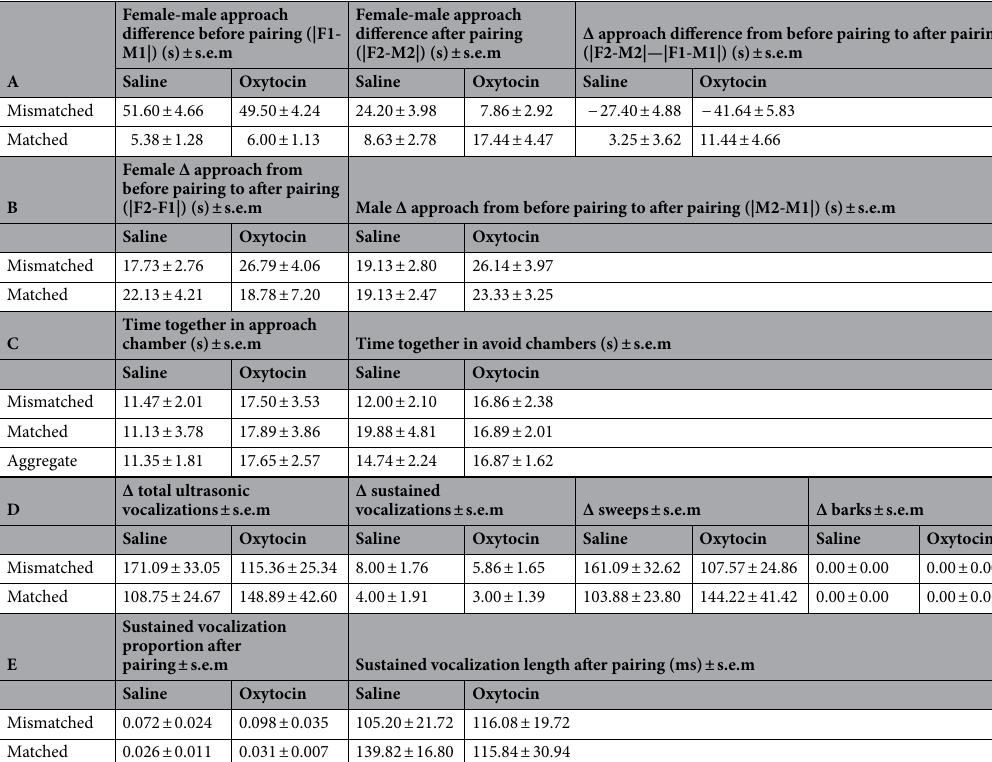
test than did saline individuals in mismatched pairs when controlling for sex, suggesting that the convergence in IN-OT mismatched pairs emerged from changes in approach by both sexes (F(1,84) = 5.257, p = 0.0244; Table 1B). IN–OT increased the amount of time pairs spent in joint approach. Complementing the analyses on the degree to which pair mates changed their behavior, we also measured time spent together as an indicator of coordination. Analysis of the amount of time paired mates spent together in either the approach chamber (the chamber closest to the bark playback speaker) or the avoid chamber (the chamber closest to the ambient noise speaker), via a 3-way interaction of pair type, treatment, and location, revealed that IN-OT spent signifi- cantly more time together in the approach chamber than saline pairs (F(1,84) = 4.311, p = 0.041) but not in the avoid chamber (F(1,84) = 0.092, p = 0.762), and no main effect of location (F(1,84) = 0.768, p = 0.383), pair type (F(1,84) = 1.645, p = 0.203), or the full interaction (F(1,84) = 0.967, p = 0.328; Fig. 3D; Table 1C). Additionally, there was a nonsignificant effect of pair type in the avoid chamber for saline groups (F(1,84) = 3.016, p = 0.086). A separate analysis that combined mismatched and matched pairs into a single category also revealed a signifi- cant main effect of IN-OT (F(1,88) = 4.066, p = 0.047), with a significant simple effect whereby IN-OT increased the amount of time pairs spent together in the approach chamber (F(1,88) = 4.543, p = 0.036) but not the avoid chamber (F(1,88) = 0.519, p = 0.473). There was also no effect of location (F(1,88) = 0.389, p = 0.535) or the inter- action of treatment and location (F(1,88) = 0.996, p = 0.321). Additionally, we did not observe any classic rodent courtship behaviors, including anogenital sniffing or following behavior (i.e. pursuing), that also occur in Cali- fornia mice 59 , nor did we observe any aggressive behavior between pair mates. Mismatched pairs produced a higher proportion of sustained vocalizations after pairing, which was not affected by IN–OT. a significant increase in the total number of vocalizations produced by pairs relative to the sum of vocalizations for pair members before pairing (F(1,38) = 70.267, p < 0.001), but no significant interaction between pair type and treatment (F(1,38) = 2.182, p = 0.148; Fig. 4A). Similarly, a GLM for number of sweeps (F(1,38) = 66.182, p < 0.001) indicated significant increases in sweep production after pairing, but no significant interaction